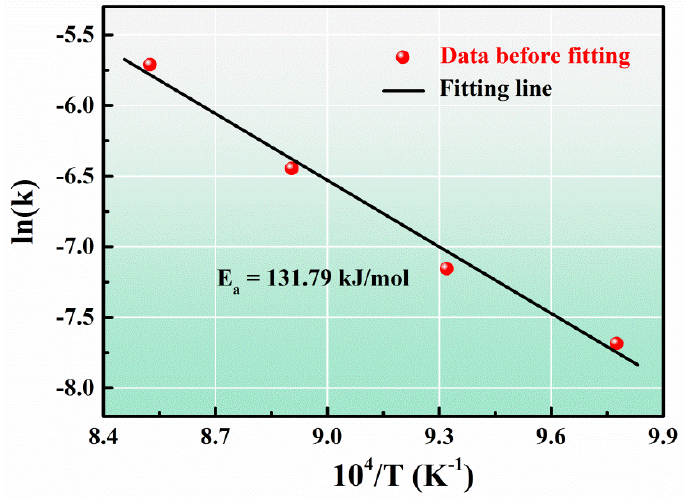
Figure 9. The Arrhenius plotting of kinetic constant k V.S. the reciprocal of isothermal wetting temperature (1/T).